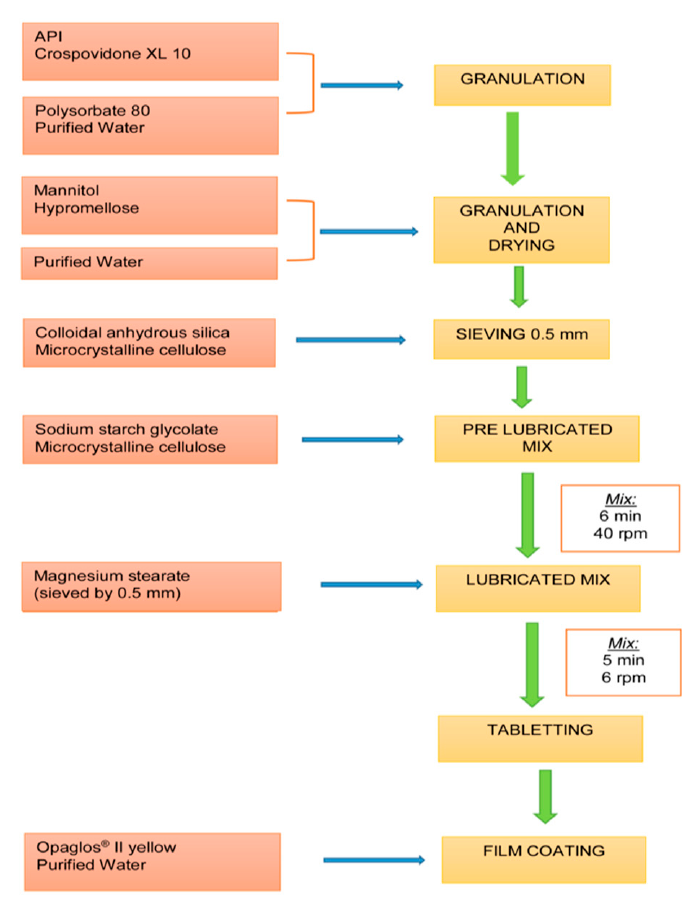
Figure 1. Industrial batch manufacturing